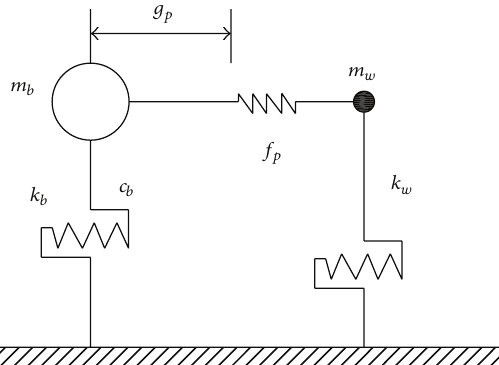
Figure 6: Simplified truss contact element of base-isolated structure for impact